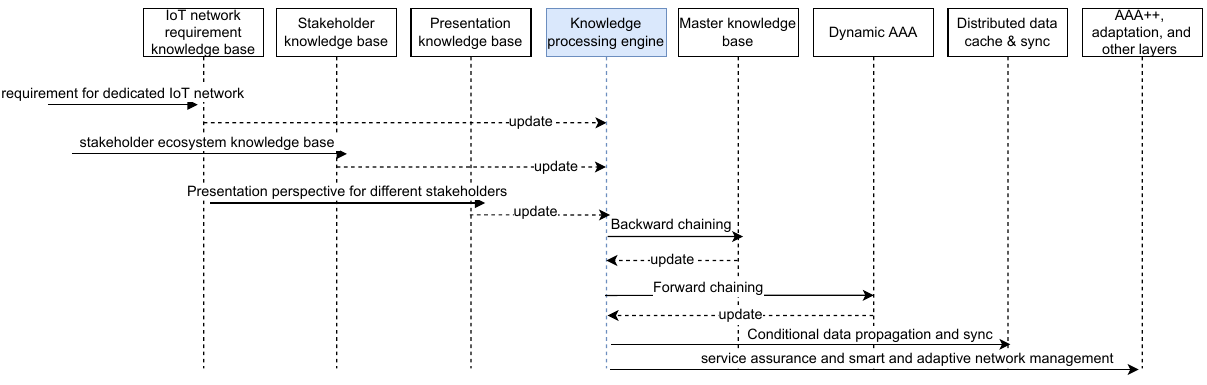
Figure 4. Sequence diagram depicting smart AAA